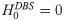
Spike rasters together with the spike histograms for STN neurons corresponding to the network model.(A) Pathological oscillatory state without stimulation (H0DBS=0). (B) Pathological oscillatory state under a periodic stimulation pattern with fDBS = 130 Hz. (C) Pathological oscillatory state under a non-periodic stimulation pattern with 〈fDBS〉 = 130 Hz and vf = 90%. (D) Pathological oscillatory state under a non-periodic stimulation pattern with 〈fDBS〉 = 130 Hz and vf = 70%. In the plots (B), (C) and (D), the stimulation patterns were applied on the STN nuclei and configured with H0DBS=7 and δ = 0.5 ms.